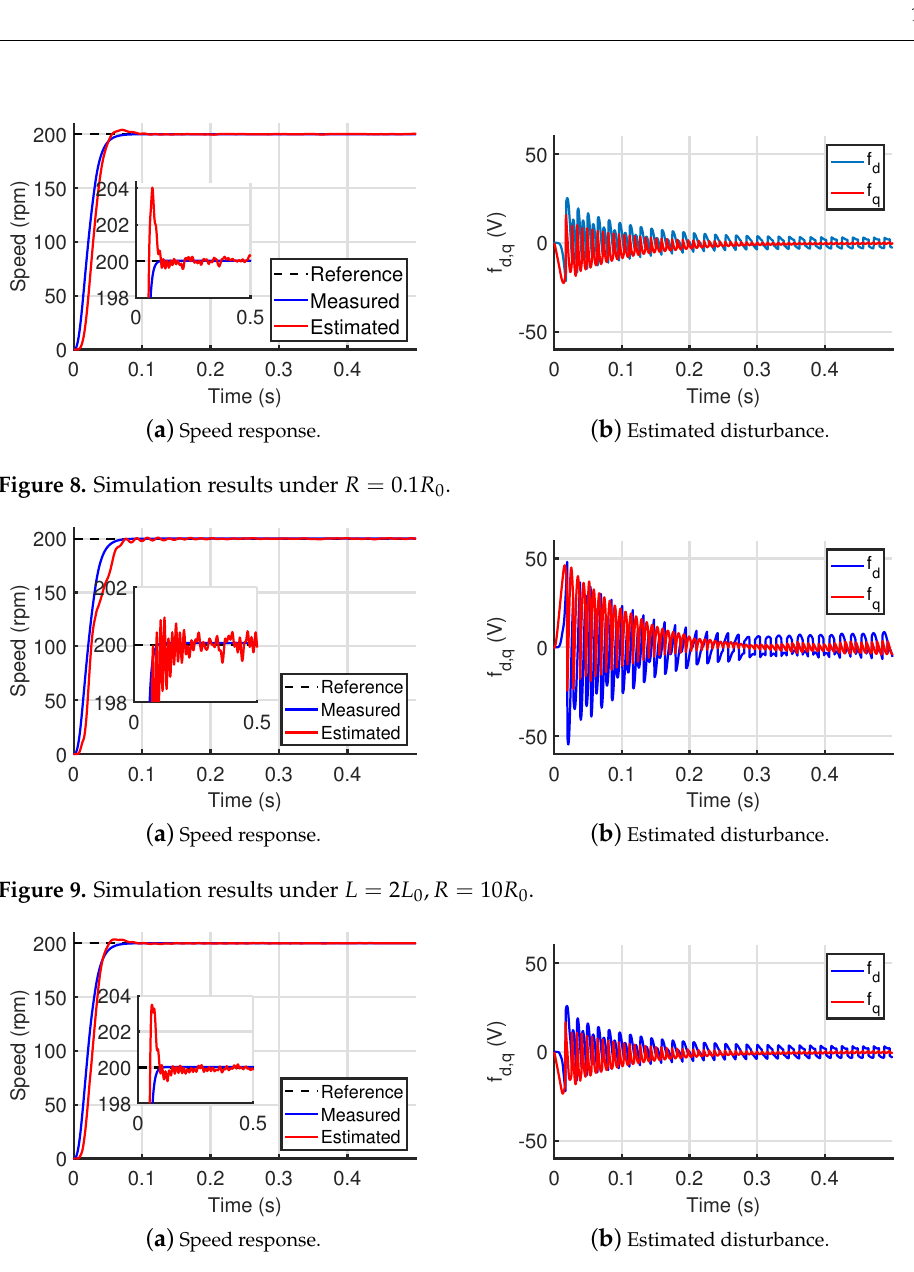
Figure 10. Simulation results under L = 0.5 L 0 , R = 0.1 R 0